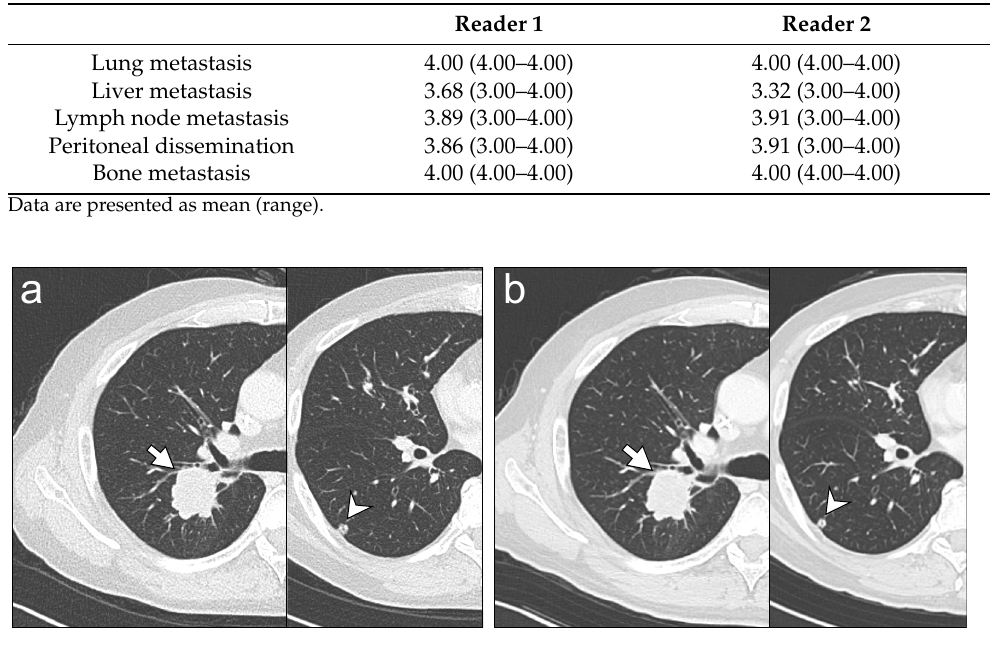
Figure 4. Representative chest CT images. Images were acquired on separate occasions from a 66-year-old male who received chemotherapy for lung metastases after colon cancer surgery. The readers identified lung metastasis lesions (arrows and arrowheads) on tin-filtered 100 kV (TF100kV) images ( a ) and standard 120 kV (ST120kV) images ( b ) with equal reliability,